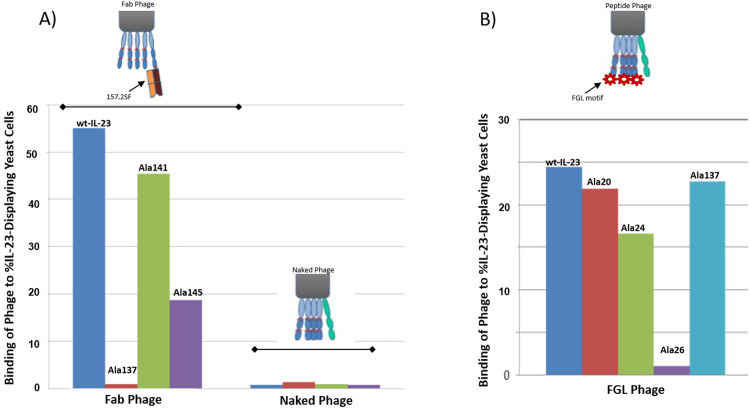
Binding of phage to IL-23 and its alanine variants of p19.A) Binding of Fab 157.2 displayed on-phage to wild-type and W137A, L141A, and K145A variants of p19 displayed on yeast. Binding of phage to %IL-23-Displaying Yeast Cells refers to mean fluorescent intensity derived from M13-AF647 antibody after the fraction of IL-23 displaying yeast cells were identified. IL-23 display was confirmed by V5-tag and p40 antibodies. Binding of phage to IL-23 was detected using anti-M13-AF647. IL-23 displaying yeast cells in the presence of M13 antibody was used for gating of all other samples. Fab-phage interacts strongly with wild-type IL-23 and does not bind to W137A variant. Naked phage does not bind to wild-type or alanine variants of p19 (n = 5). B) FGL-containing peptide phage binds to wild-type and all the alanine variants of p19 except for W26A. FGL-phage binds at reduced levels to L24A (n = 2).